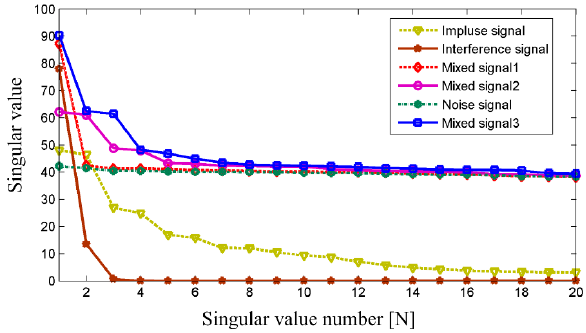
Figure 6. The singular components of these six signals.